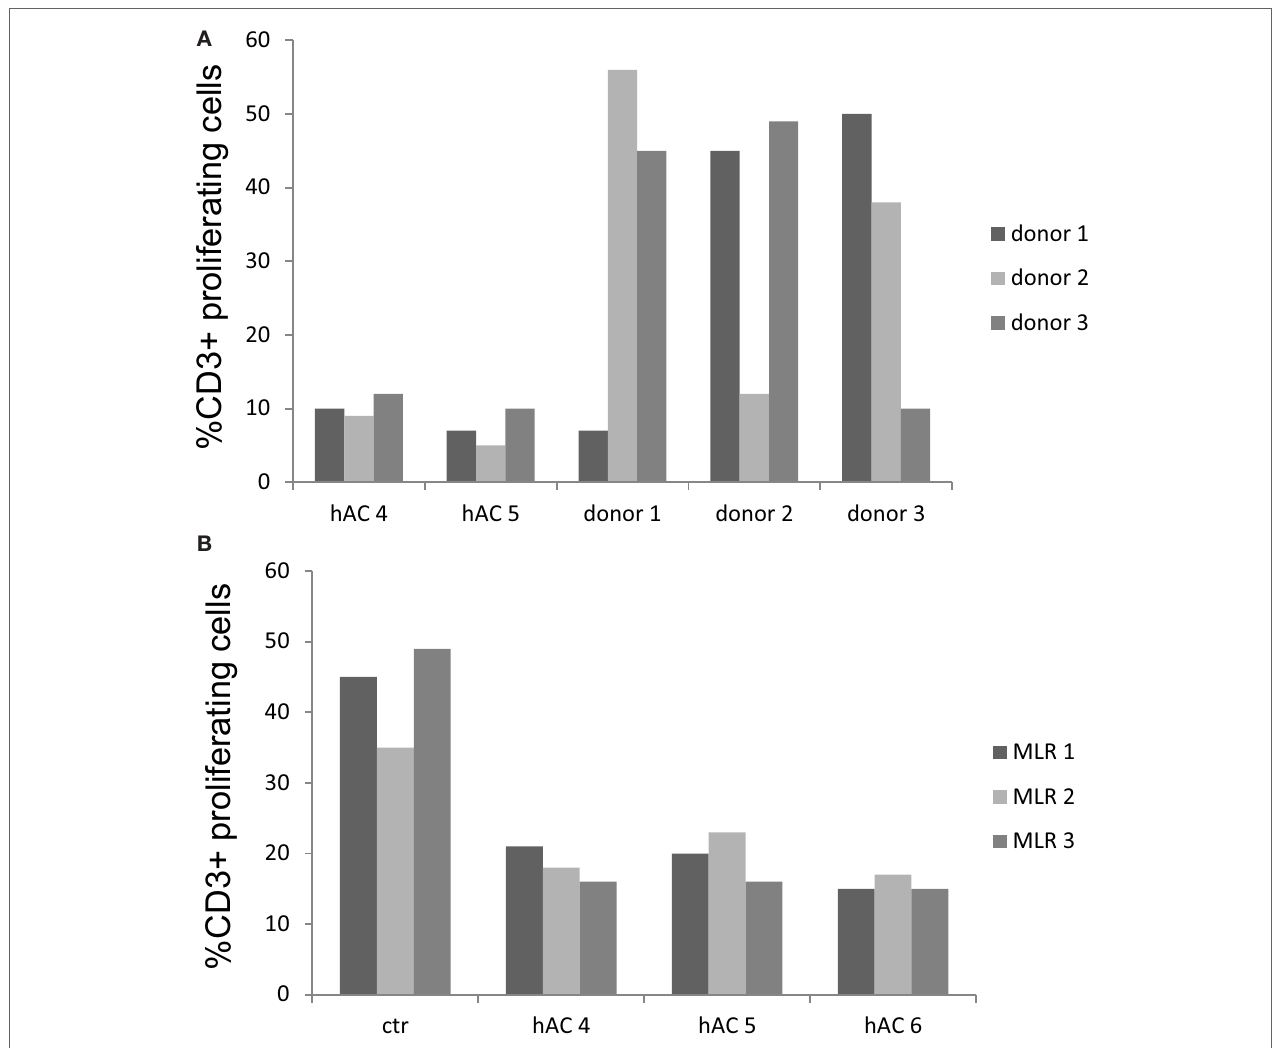
FigUre 7 | human ac do not stimulate allo-response and inhibit Mlr as a third party . (a) Allogeneic hAC were used as stimulator of PBMC of three donors labeled with CFSE at the PBMC:hAC ratio of 10:1. Proliferation was evaluated at day 7 and it was assessed as decrement of CFSE content in CD3 + T cells (identified by indirect immunofluorescence with anti-CD3 mAb UCHT-1 followed by goat APC-conjugated anti-mouse isotype specific antiserum). Results are expressed as % of CD3 + T cells with decrement of CFSE content compared to PBMC cultured alone. MLR between the three different PBMC donors was shown for comparison to define whether PBMC can indeed proliferate upon allo-recognition. (B) Regulation of MLR with hAC as a third party. MLR were set up in the presence of hAC (as a third party) at the responder PBMC:hAC ratio of 10:1 and proliferation evaluated as in (a) as decrement of CFSE content in CD3 + responder T cells. Ctr: level of proliferation of CD3 + T cell in the MLR. Results are expressed as % of CD3 + T cells with decrement of CFSE content. Responder PBMC cultured alone showed a proliferation of